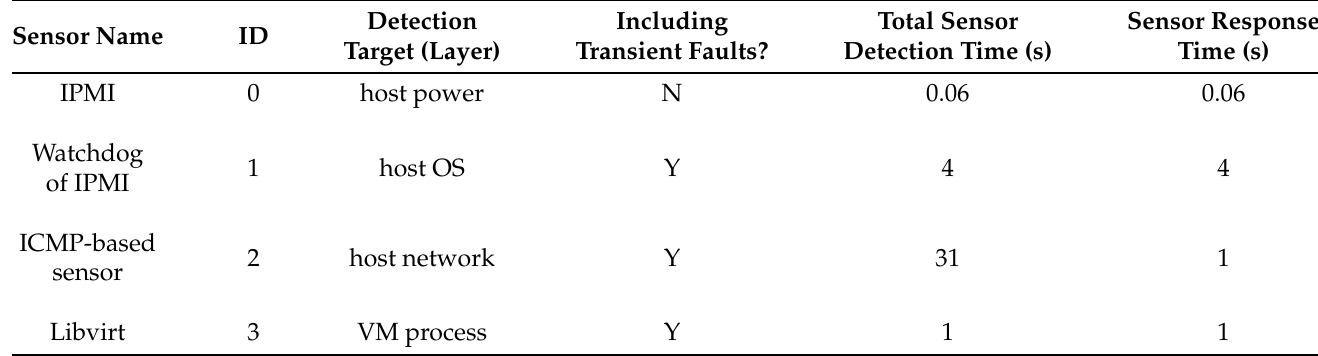
Table 8. Layer sensor and corresponding detection information. IPMI: Intelligent Platform Management Interface. ICMP: In- ternet Control Message